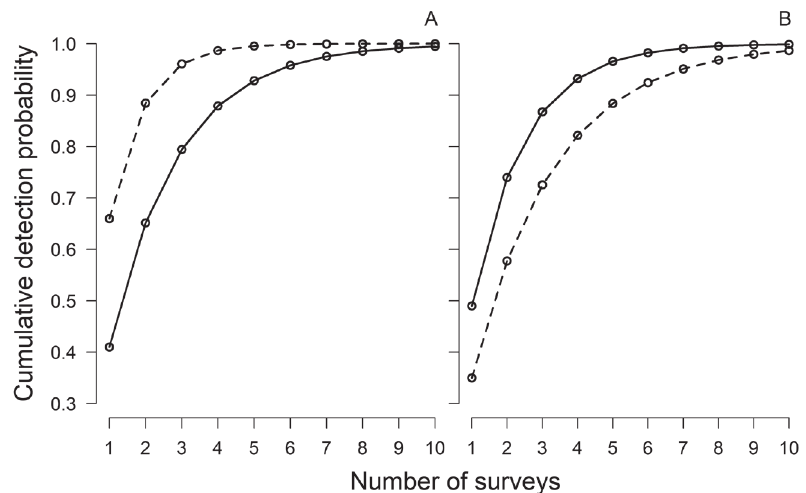
Figure 3. Cumulative detection probability as a function of the number of surveys for cave crayfishes (panel A) and cavefishes (panel B). Solid lines eDNA surveys and dashed lines are visual surveys. Cumula- tive detection probability ( p ) was calculated as: p = (1 - (1 – p ) k where p is detection probability at mean , c c and reference levels (i.e., visual surveys, water not flowing, cave crayfishes, and coarse substrate) of predic- tor variables and k is the number of surveys.